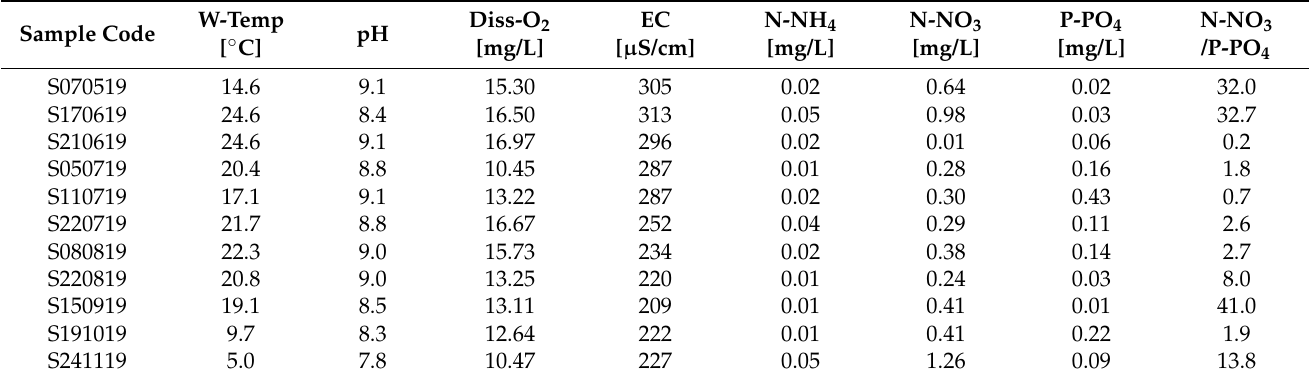
Table 1. The physical and chemical parameters of water in Stryk ó w artificial reservoir during the research season; sample code consist of: S (Stryk ó w reservoir), and date of